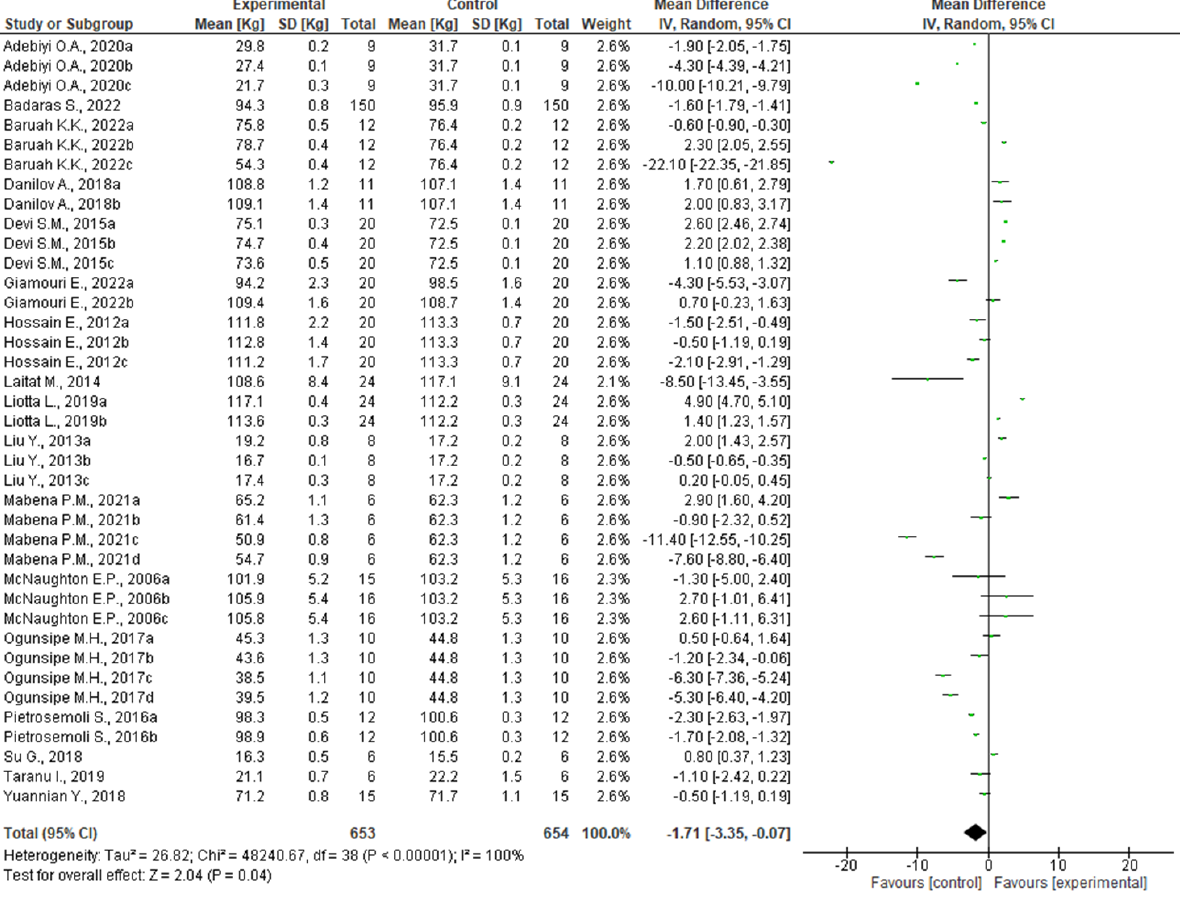
Figure 7. Forest diagram representation of growth performance of swine fed a diet inclusive of plant waste. Data were extracted from 17 articles [111 – 127] and plotted against the mean difference. Each horizontal line in the graph represents an individual study, with the experimental mean value displayed as a green box. For each study, if the horizontal line (95% CI) crosses the vertical line, no significant differences can be observed between experimental and control groups. The black diamond at the bottom of the forest plot represents the average effect size calculated from the combination of the results from all selected studies.